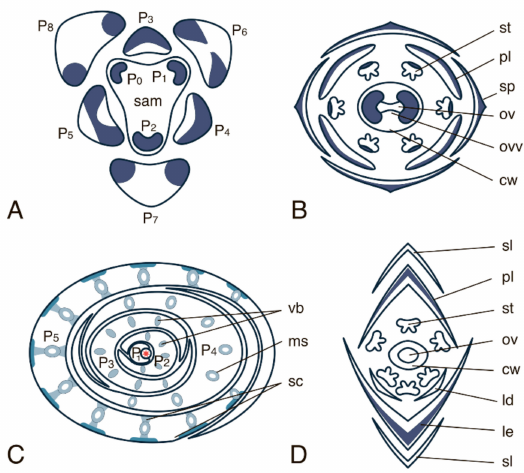
Figure 3. Expression pattern of the “vegetative YABBY ” group. ( A ) Line drawing of the cross-section through the vegetative apex of A. thaliana . ( B ) Flower diagram of A. thaliana . ( C ) Line drawing of the cross-section through the vegetative apex of O. sativa . ( D ) Flower diagram of O. sativa . Patterns of “vegetative YABBY” expression are marked in blue colour and are based on descriptions and photos of in situ RNA-RNA hybridization from [44,55,57,63,64]. Here and in Figures 4–6, sam—shoot apical meristem, P0-P7—successive stages of leaf primordia and leaf development, vb—vascular bundle, ms—mestome sheath, sc—sclerenchyma, sp—sepal, pt—petal, st—stamen, cw—carpel wall, ov—ovary, ovv—ovarian valves, lm—lemma, pl—palea, ld—lodicule, sl—sterile lemma (empty glume). The asterisk in ( C ) marks the SAM.